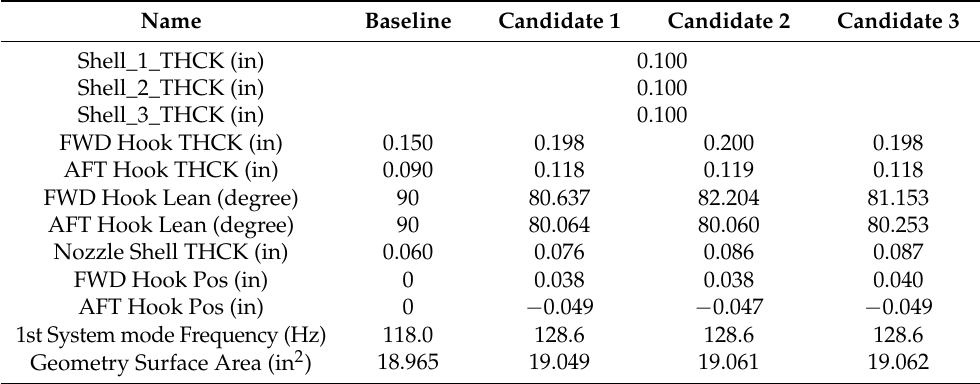
Table 6. Optimization results—Objective function J 2A